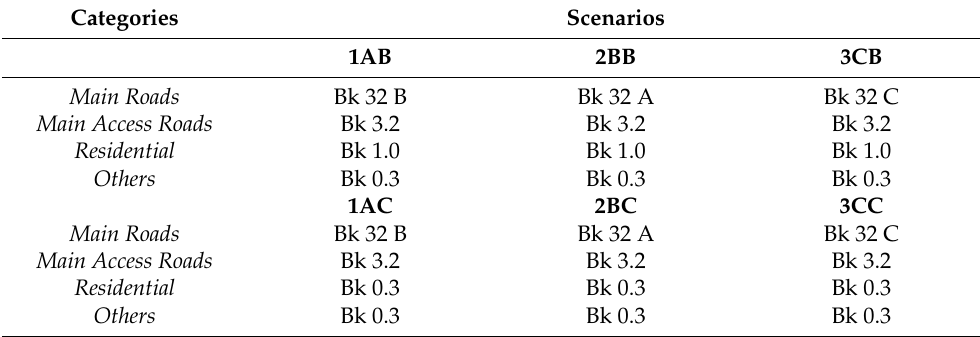
Table 7. Scenarios modelled in